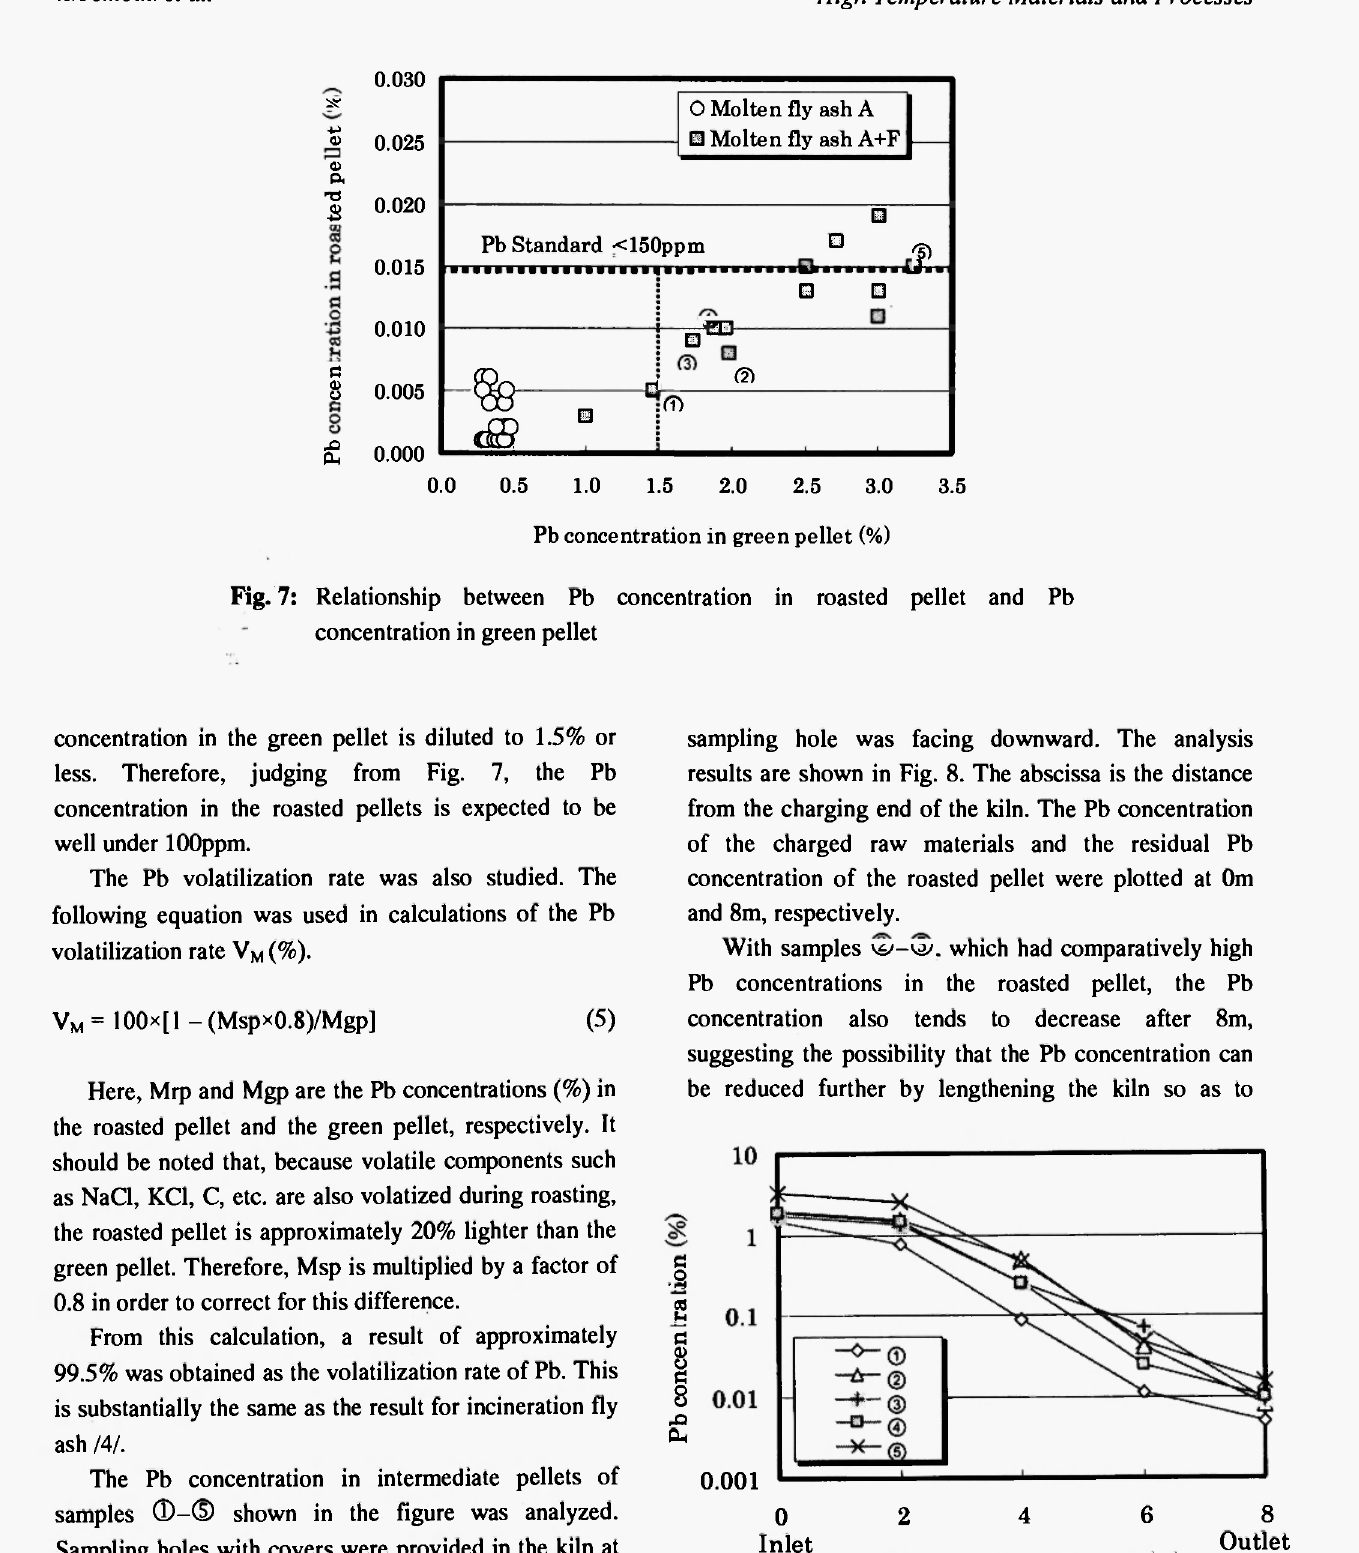
Changes of Pb concentration in